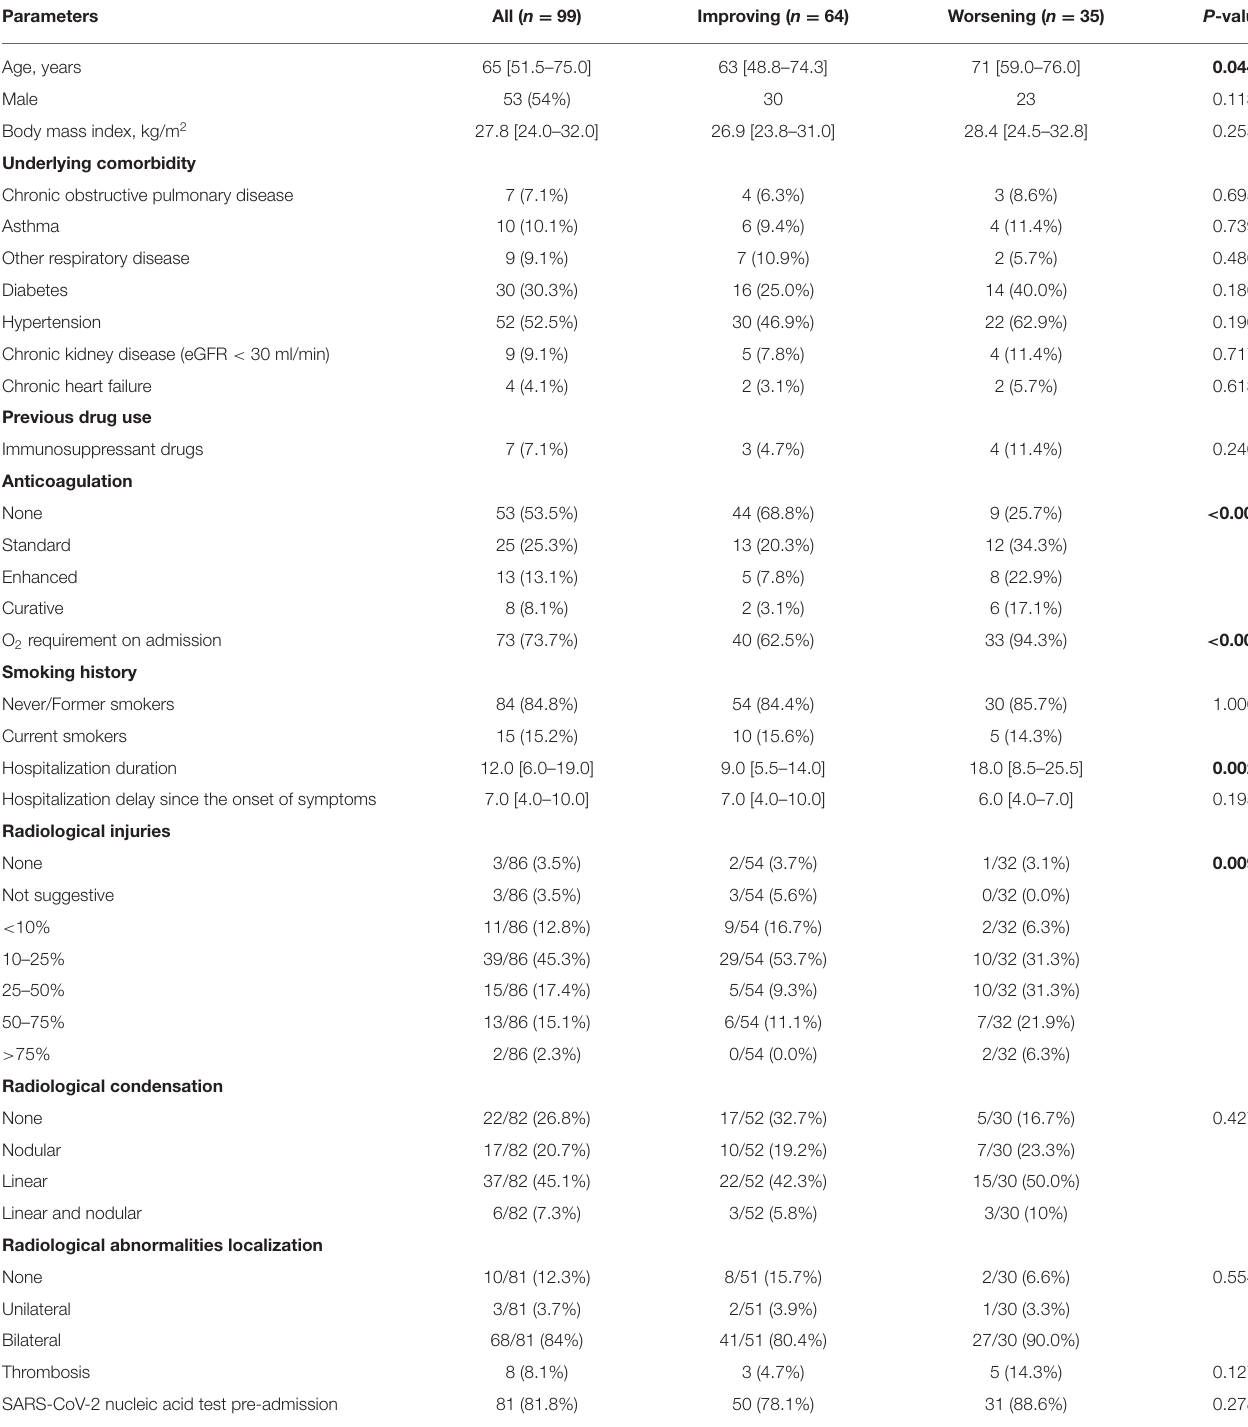
TABLE 1 | Epidemiological, demographic, and clinical characteristics of the 99 hospitalized patients with COVID-19 infection.